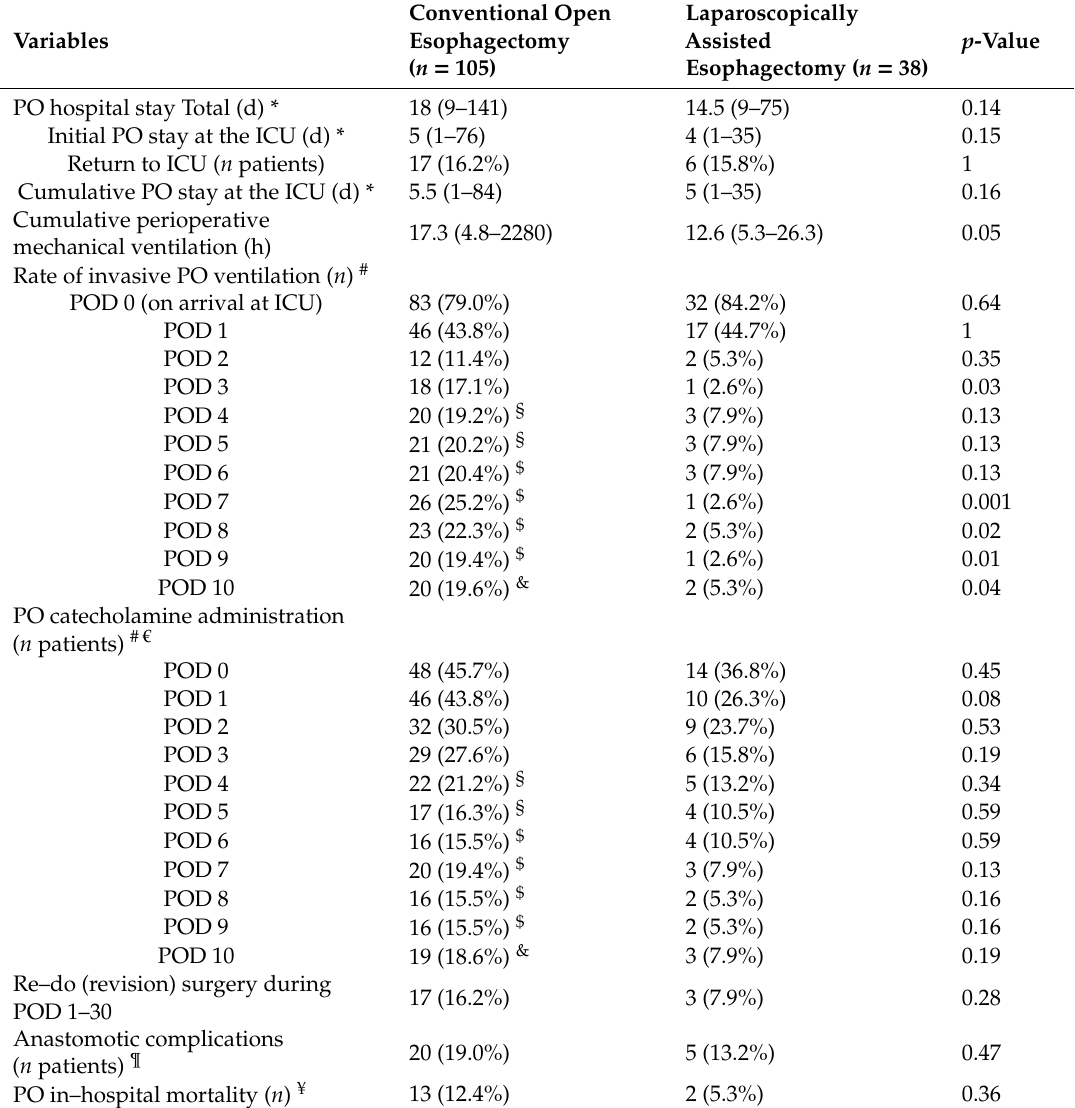
Table 4. Perioperative